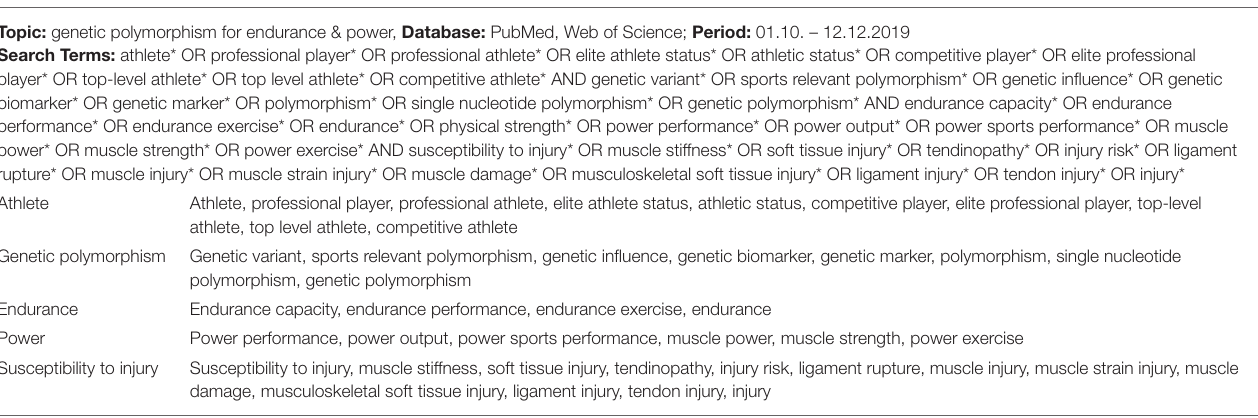
TABLE 1 | Search strategy & search history. Heading Search terms and synonyms